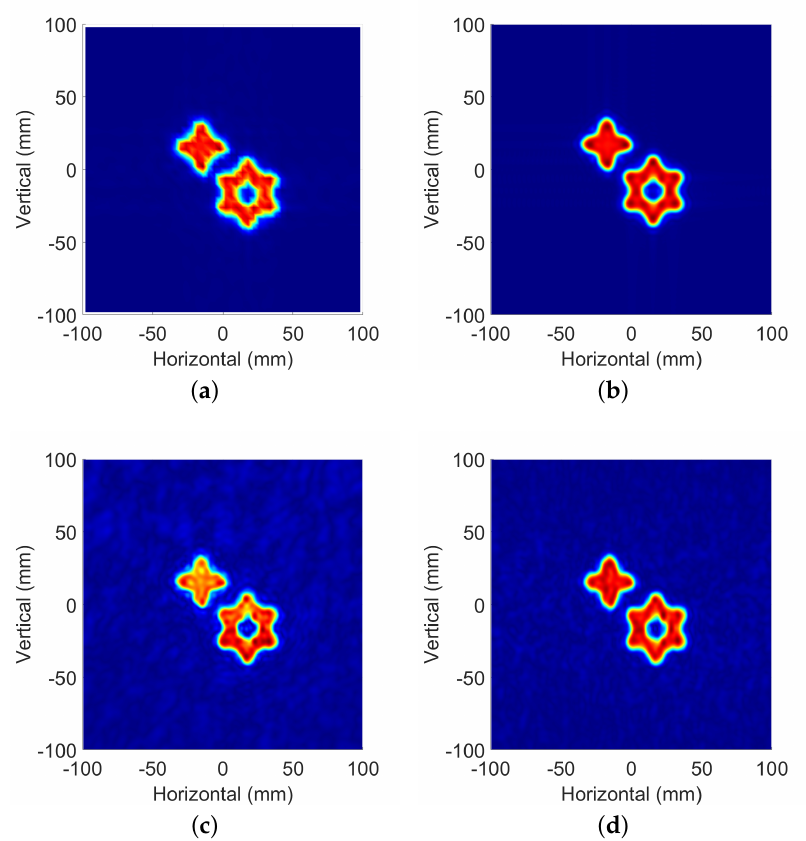
Figure 8. Reconstruction results under different conditions: ( a ) reconstruction results of the SAR data where d x = d y = 4 mm without preprocess; ( b ) reconstruction results of the SAR data where d x = d y = 4 mm with preprocessing proposed by this article; ( c ) reconstruction results of the SAR data with USR = 30% by CS method; ( d ) reconstruction results by the method proposed by this article where the USR of data is